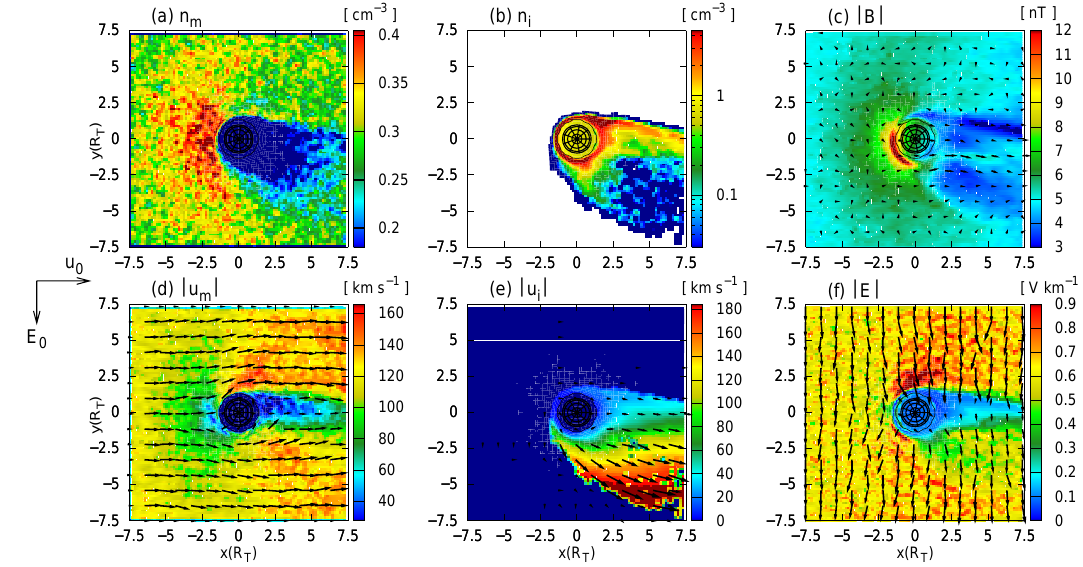
Fig. 10. Transition from supermagnetosonic to submagnetosonic flow – Cut through Titan’s equatorial plane which is parallel to the undis- turbed convective electric field. The physical quantities shown in the figure are the same as in Fig. 9. Mach numbers of the upstream plasma flow: M A =1.87 (alfv´enic), M S =1.08 (sonic) and M MS =0.94 (magnetosonic).